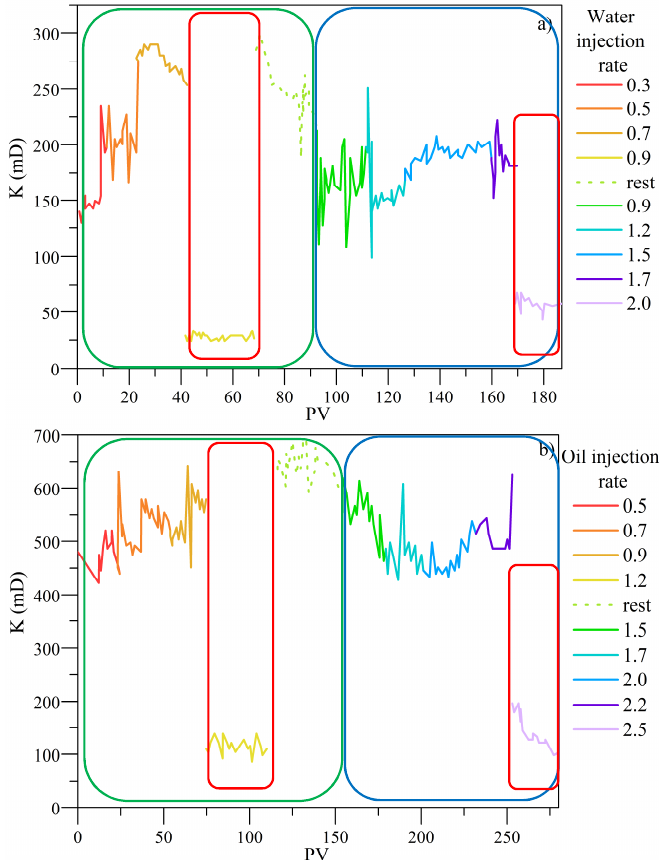
Figure 14. Critical rate to ( a ) water—before (green box) and after treatment (blue box) and ( b ) oil—before (green box) and after treatment (blue box) composed of MgO-based nanofluid with 800 mg · L − 1 of CTAB